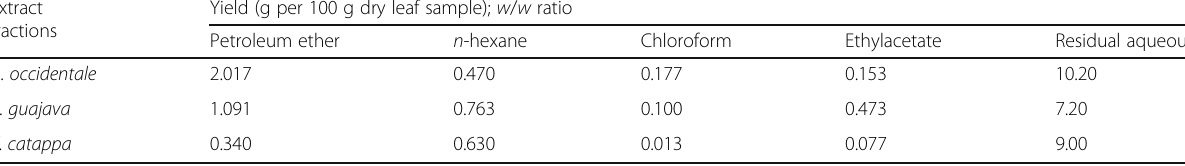
Table 1 Yields of fractionated leaf extracts Extract Yield (g per 100 g dry leaf sample); w / w ratio fractions Petroleum ether n -hexane Chloroform Ethylacetate Residual